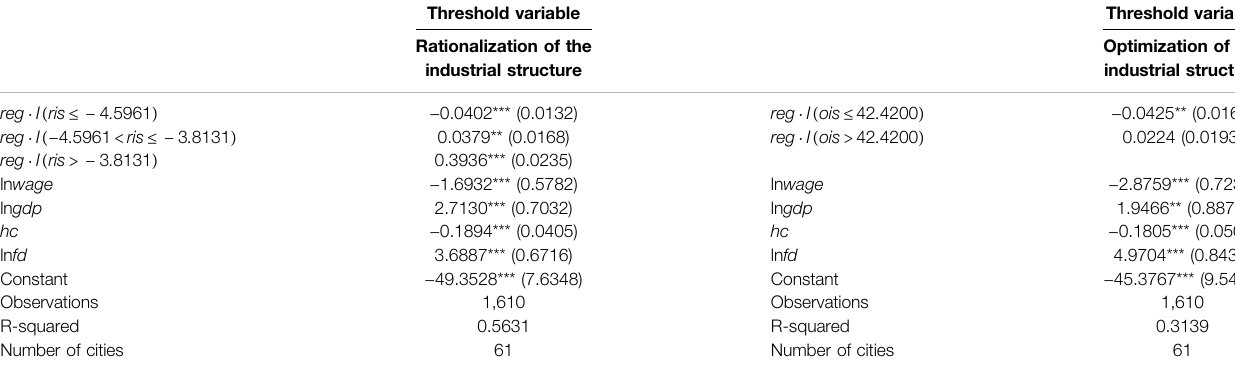
TABLE 7 | Parameter estimation results of the coal resource city panel threshold